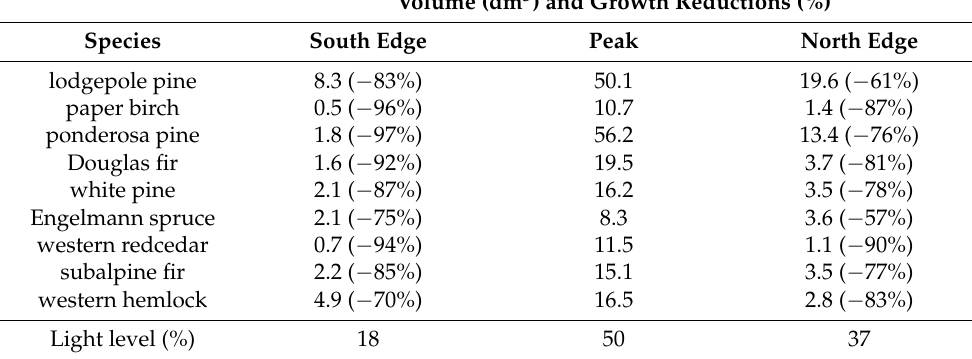
Table 4. Species volume at different gap positions and percent growth reductions relative to the peak (in parenthesis). Edge positions are measured observations within 5 m distance from the gap edge. The bottom row reports light transmittance as percentage of the open. Volume (dm 3 ) and Growth Reductions